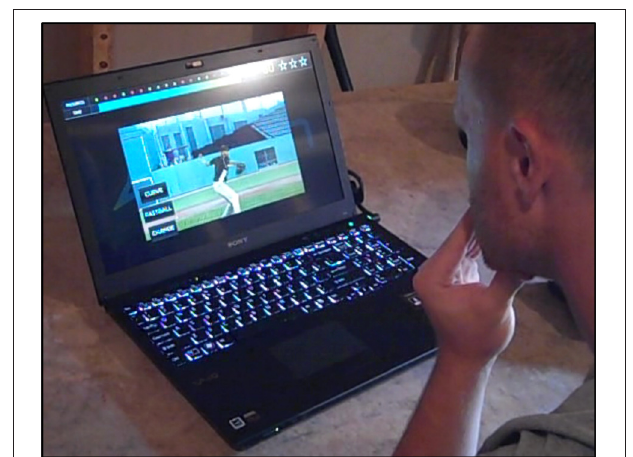
FIGURE 3 | Video-Simulation (courtesy Axon Sports